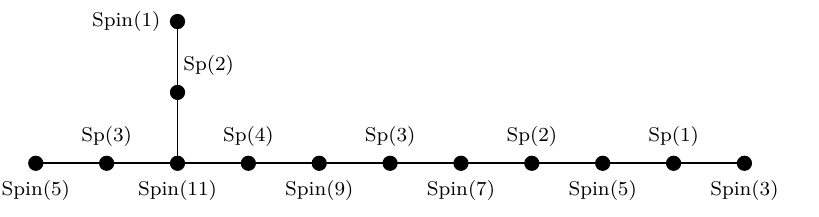
+ x 5 + x 5 + x 5 = 0 . Here, 1 2 3 4